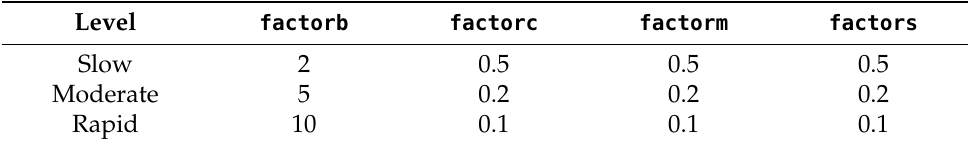
Table 4. Grouping levels and hyperparameter values for MultFactor.